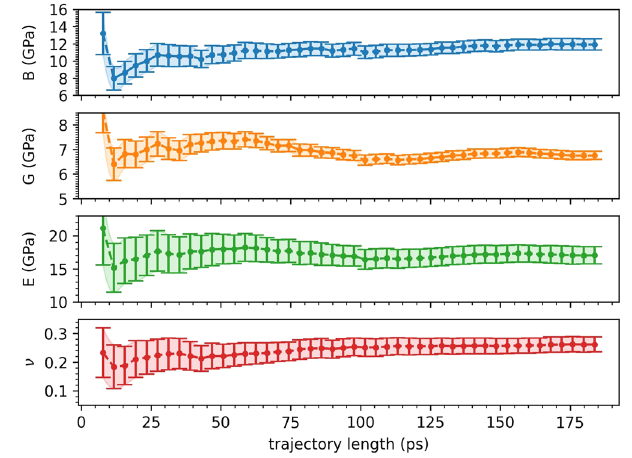
Fig. 4 Dependence of the elastic moduli and Poisson ’ s ratio on the length of the 600 K- NPT CP molecular dynamics trajectory for t-LGPS. Each point corresponds to a trajectory which is n -block long, with n = 2, . . N blocks, N being the number of blocks that we have chosen for the whole trajectory, in this case 47 (see Fig. 3), each block containing the # data (~2000 data, ~4 ps) as determined from Fig. 3. The error bars are the standard errors of the moduli for each trajectory, obtained from the variance over the blocks, since these blocks are already uncorrelated and there is no need to repeat the block analysis in Fig. 3 for each of these calculations. Analogous plots for o-LGPS, t-LGPO, and o-LGPO are reported in Supplementary Figure